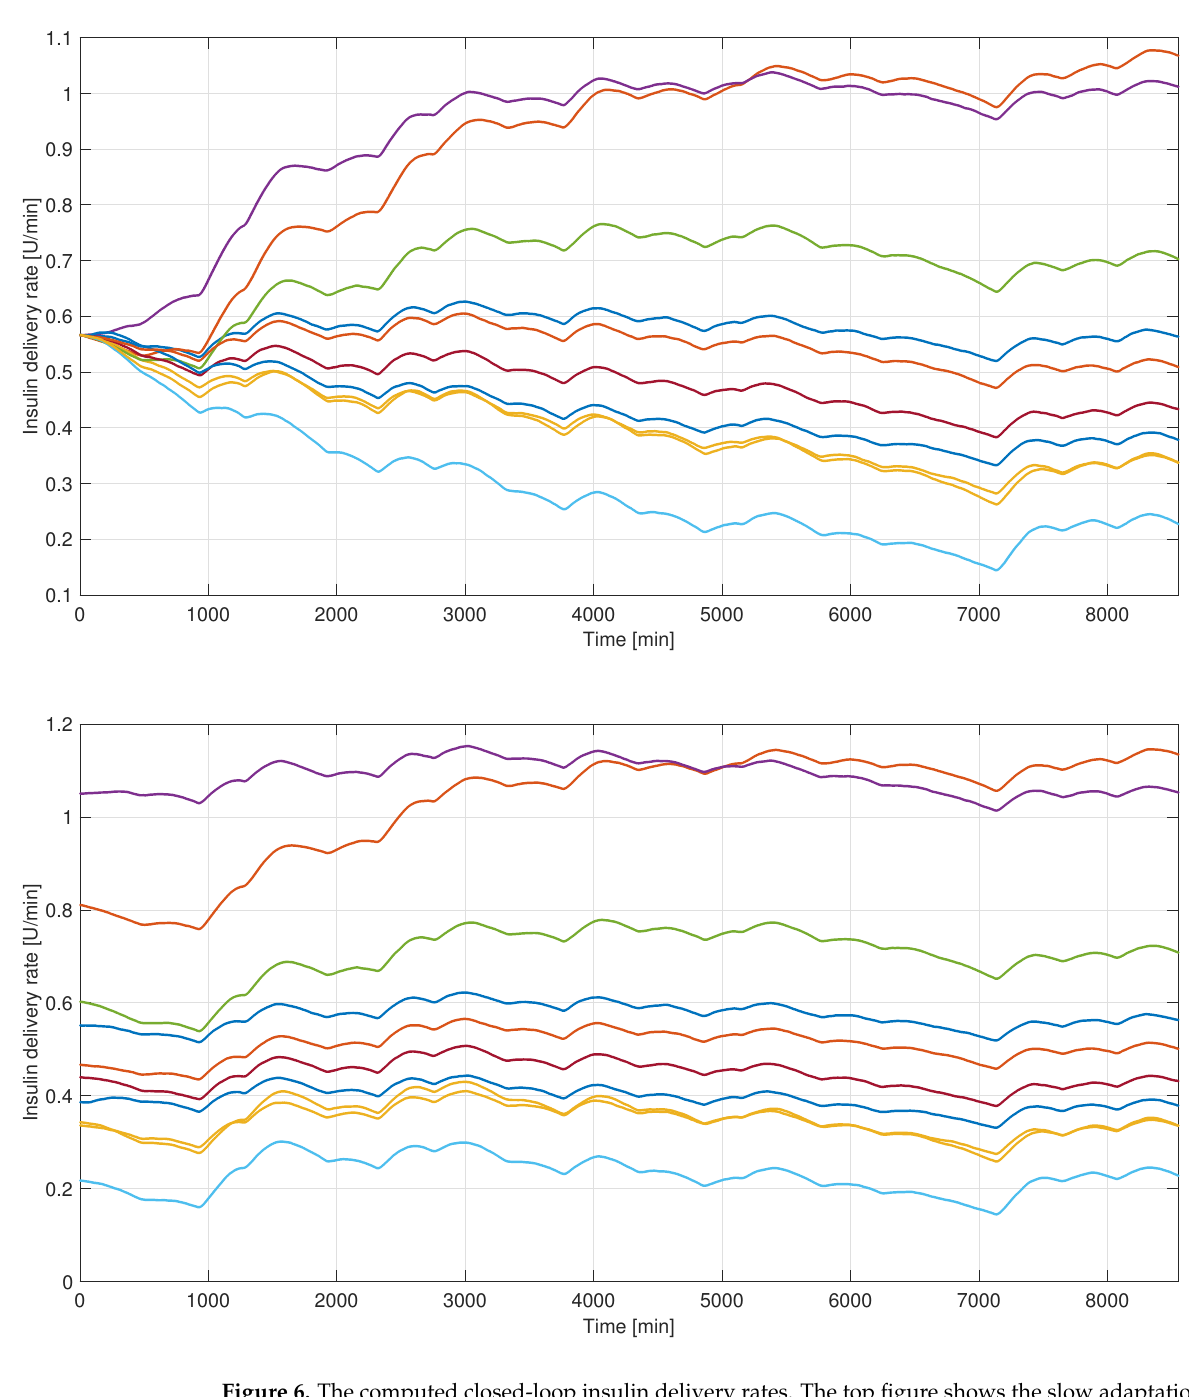
Figure 6. The computed closed-loop insulin delivery rates. The top figure shows the slow adaptation case, while the bottom corresponds to the fast. The signals closely resemble the deformed signals. One can see that the input signals in both cases respected the actuator limitations, hence the control strategies were feasible in